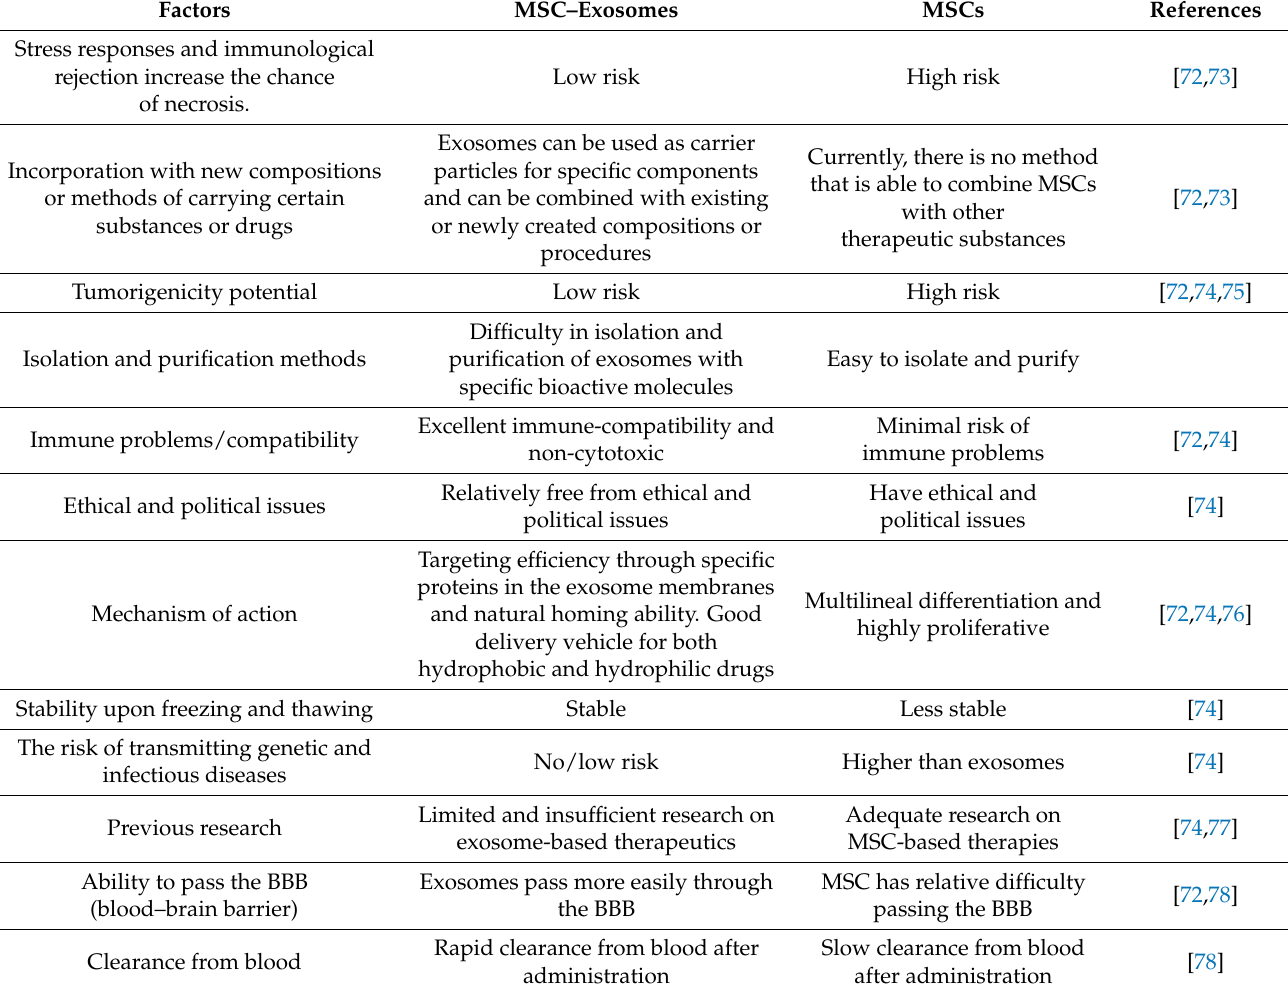
Table 2. Summary of the differences between MSC and MSC–exosome